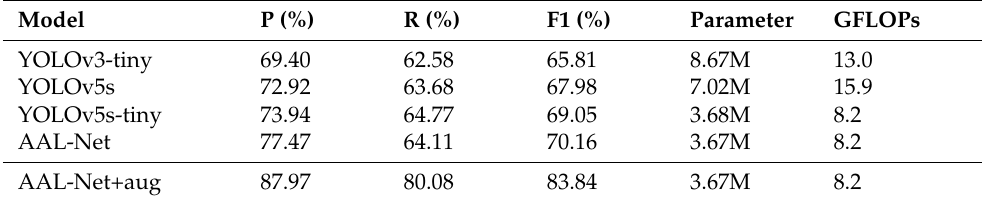
Table 3. Comparison of experimental results with existing methods in the self-made dataset.